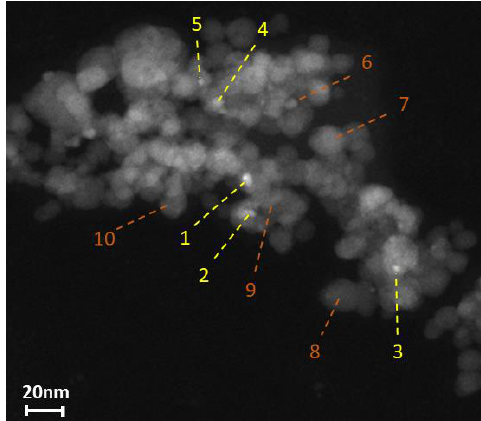
Figure 5. HAADF-STEM micrograph of 3% AgPd-Fe 3 O 4 sample, with SA-EDS analysis spots marked and numbered: chemical analyses in brighter particles (1–5 spots) showed AgPd wt.% >12, with an averaged Ag:Pd atomic ratio of 0.2:0.8 (0.1 SD), while in 6–10 spots AgPd wt.% <0.9.